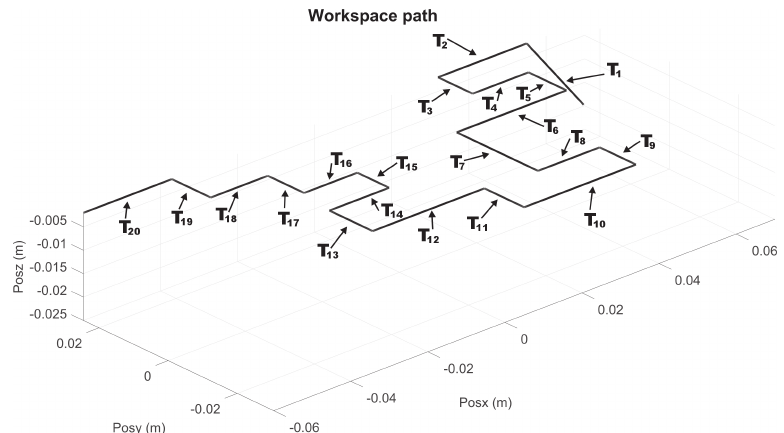
Figure 11. Solution to the maze MCM of first exercise.